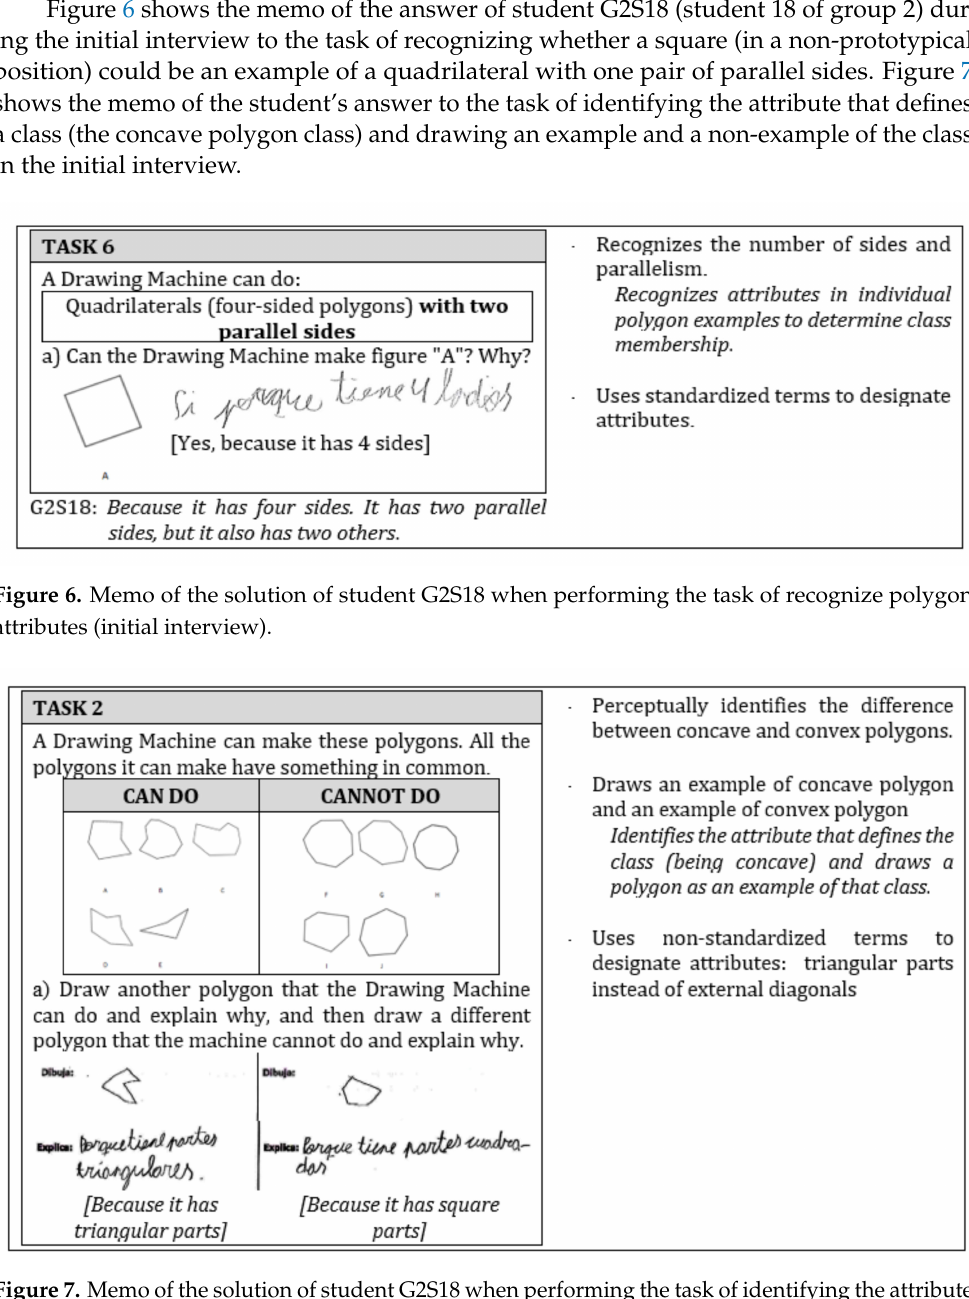
Figure 7. Memo of the solution of student G2S18 when performing the task of identifying the attribute that defines a class and represent an example and a non-example of the class (initial